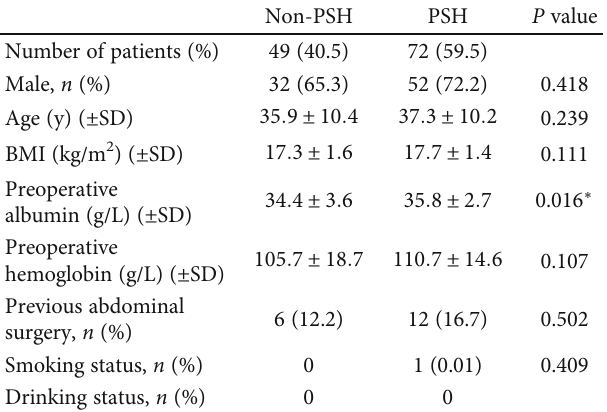
Table 1: Demographic and clinical characteristics of study cohorts.